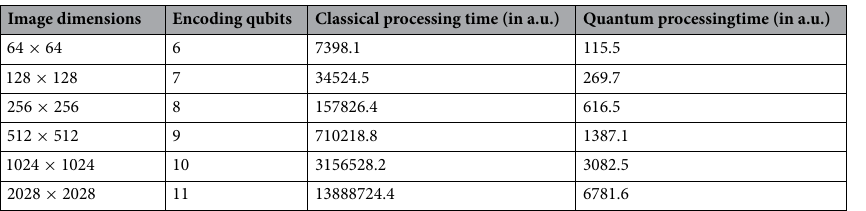
Table 3. Numerical estimates of the time complexities (in arbitrary units) for the classical and the quantum protocol for different input image dimensions along with the corresponding number of qubits required for